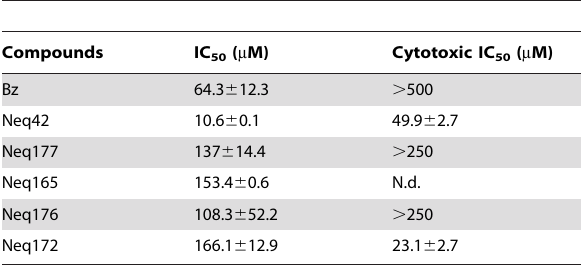
Table 3. Trypanocidal activity and cytotoxicity of cruzain inhibitors evaluated against Tulahuen lacZ